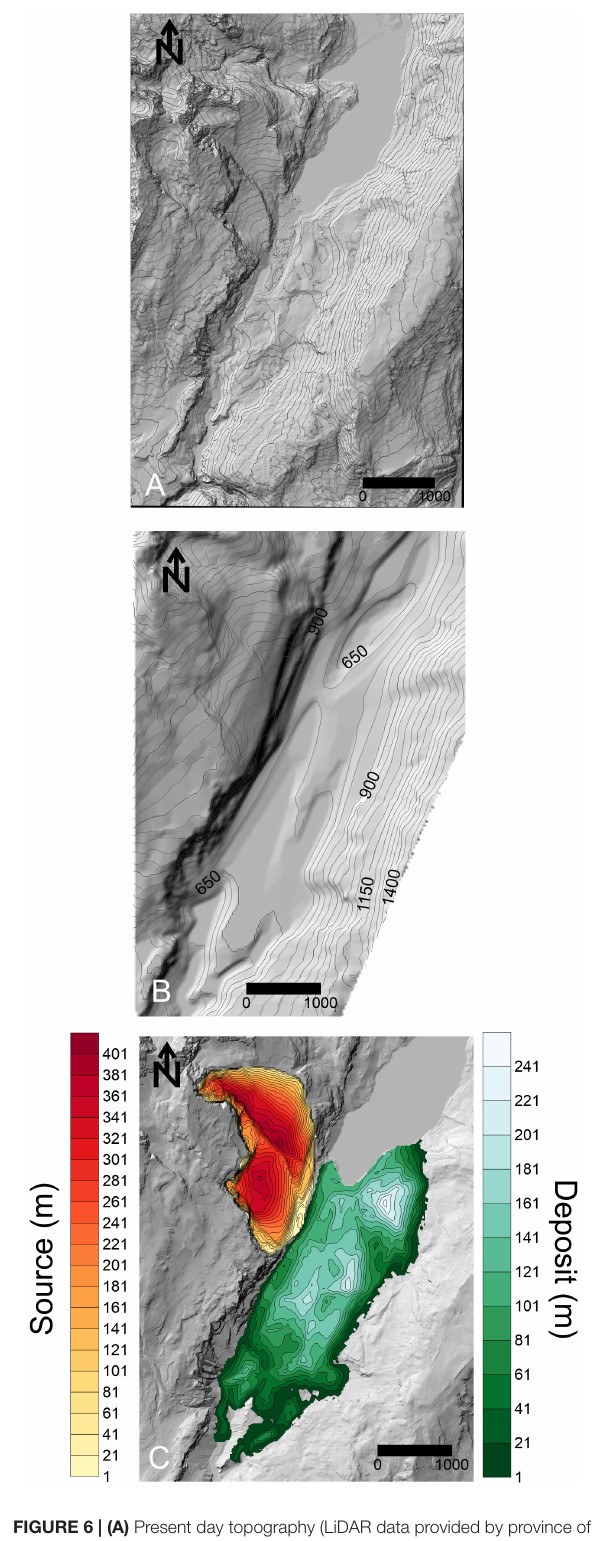
FIGURE 6 | (A) Present day topography (LiDAR data provided by province of Trento). (B) Reconstructed pre-failure topography. (C) Reconstructed source and deposit thickness, only material reconstructed above the present - day lake is